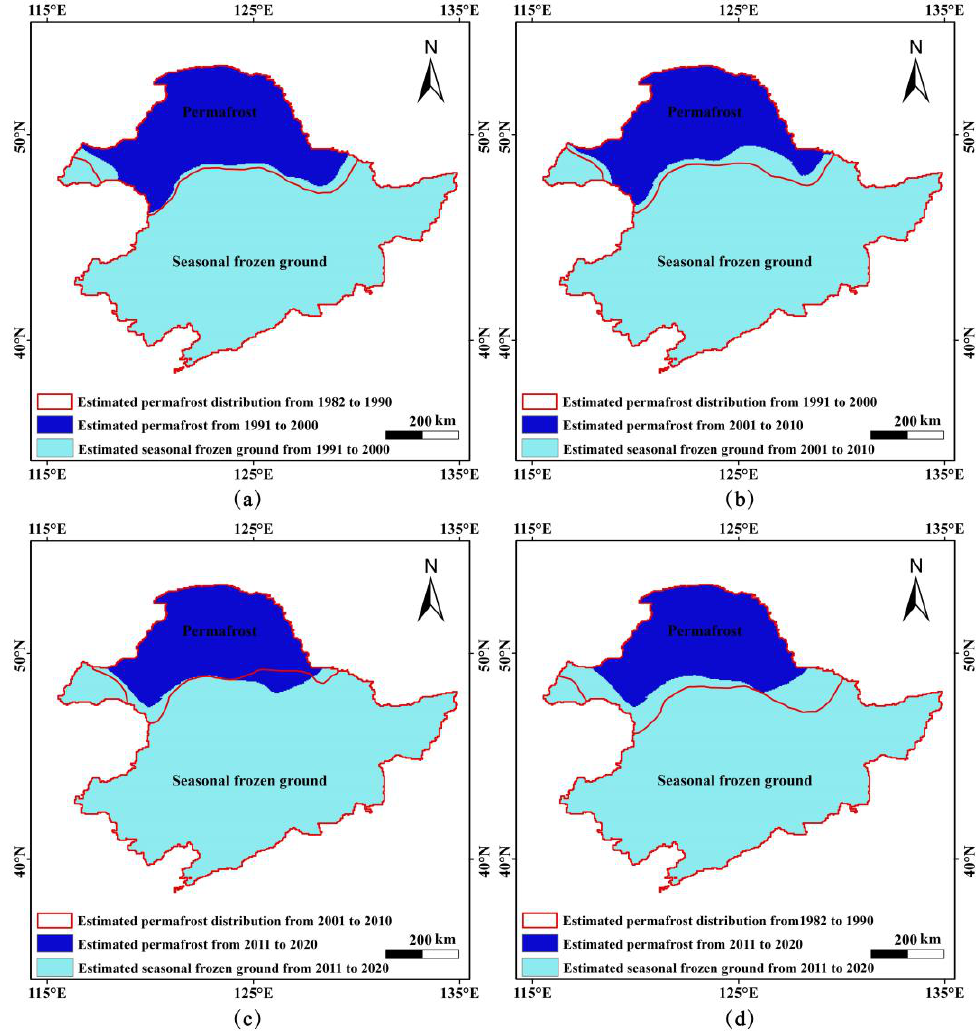
Figure 3. The estimated permafrost distributions ( F > 0.5) and decadal differences in northeast China